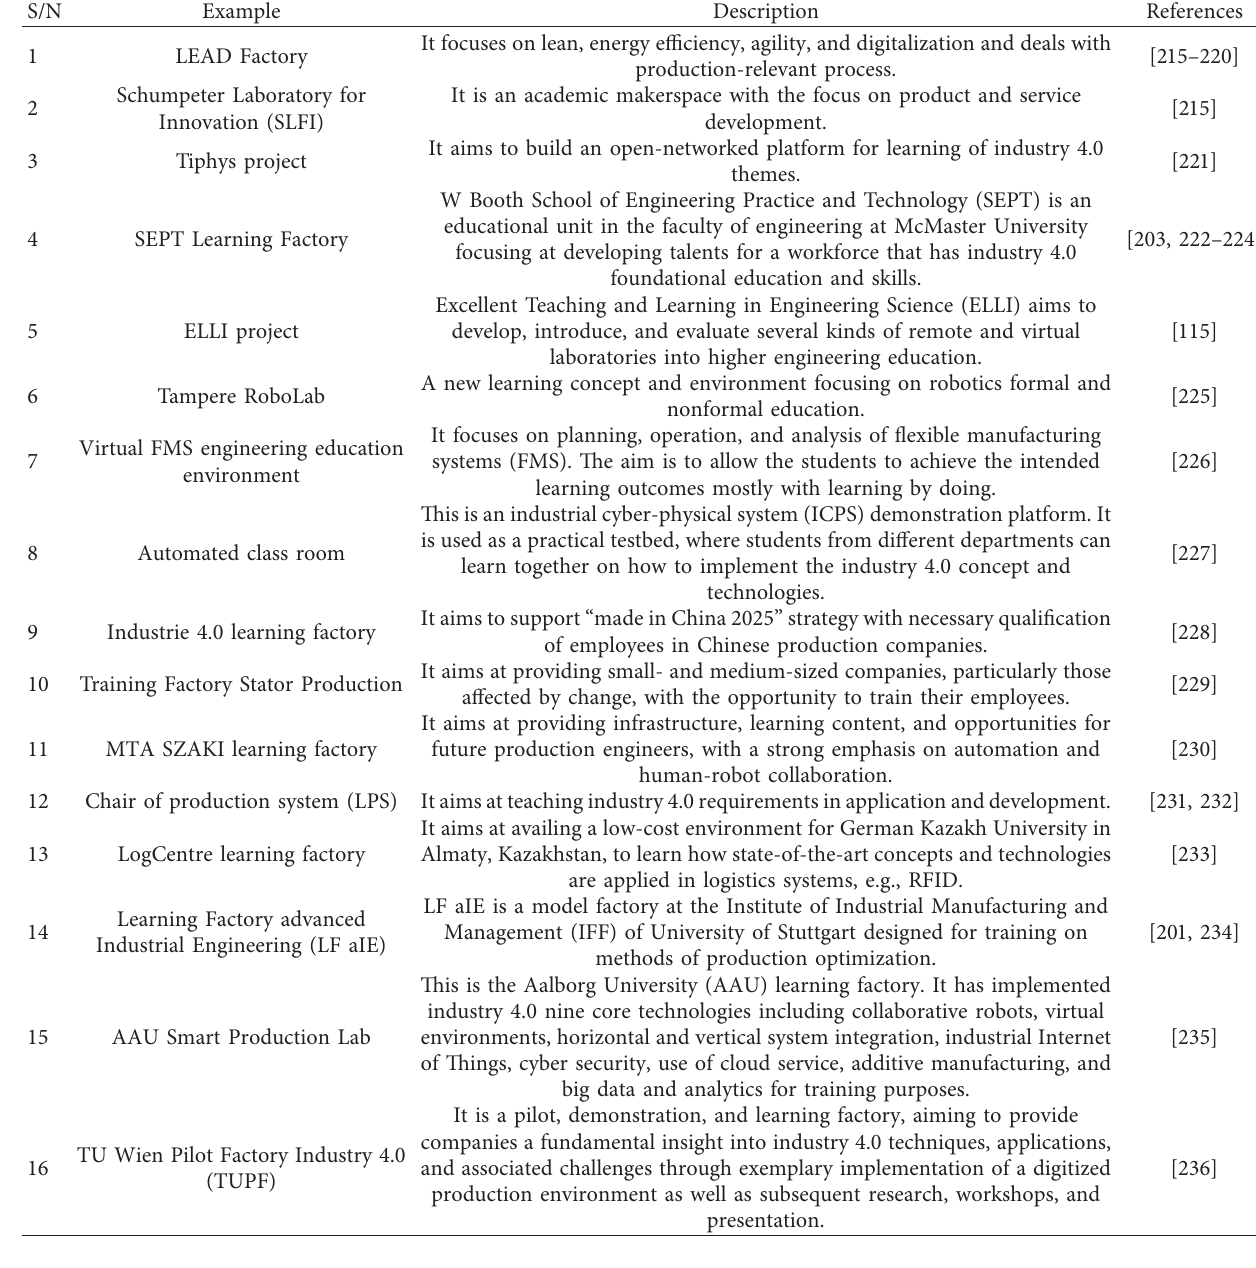
Table 5: Examples of learning